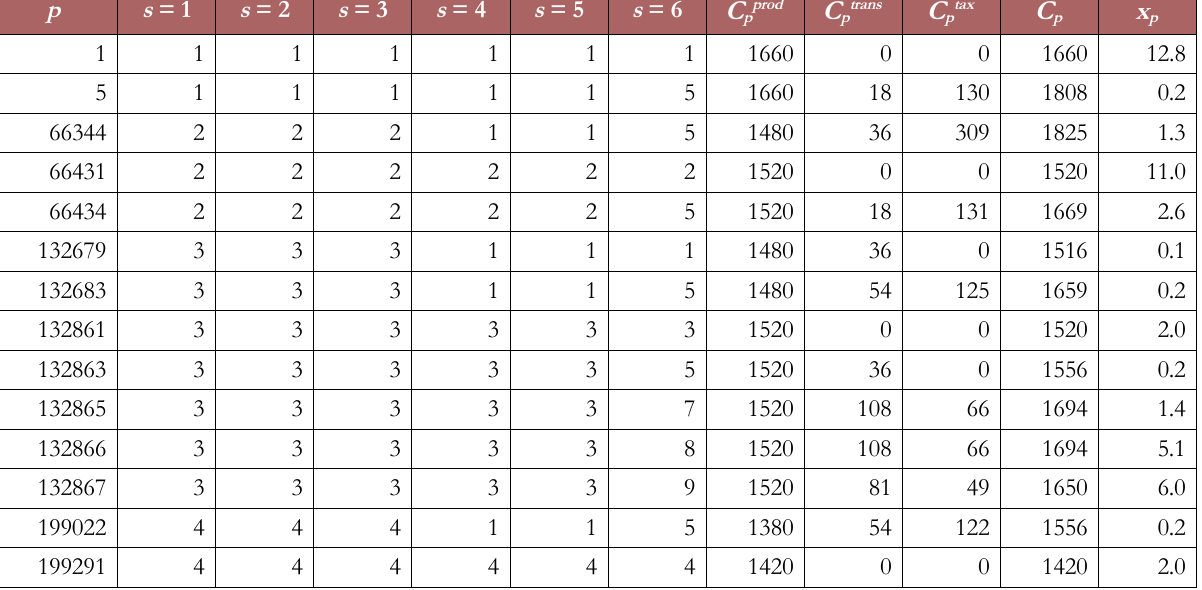
Table 8. The list of non-zero flows for production-transportation cost